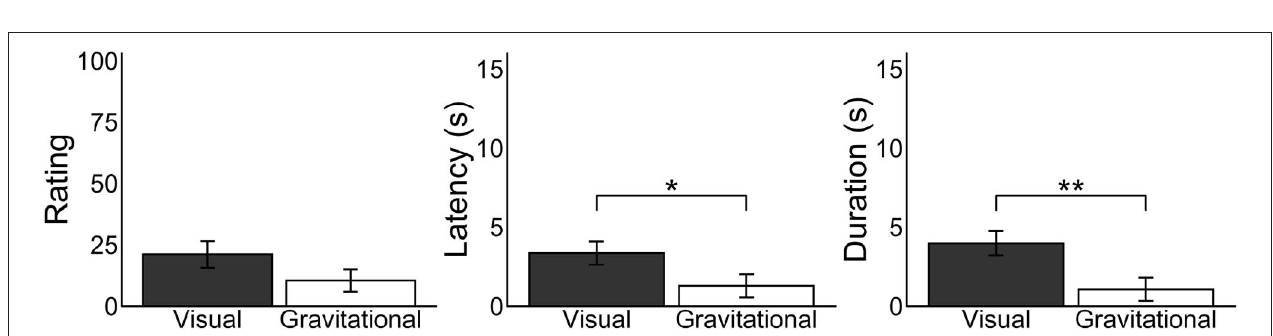
FIGURE 5 | Mean vection measures for each lateral location of visual field in the sitting posture. Error bars represent standard error of the mean. Note that the UGVF and LGVF in the sitting posture were defined based on the individual recumbent direction in the recumbent condition. See Figure 4A for the details of UGVF and LGVF.